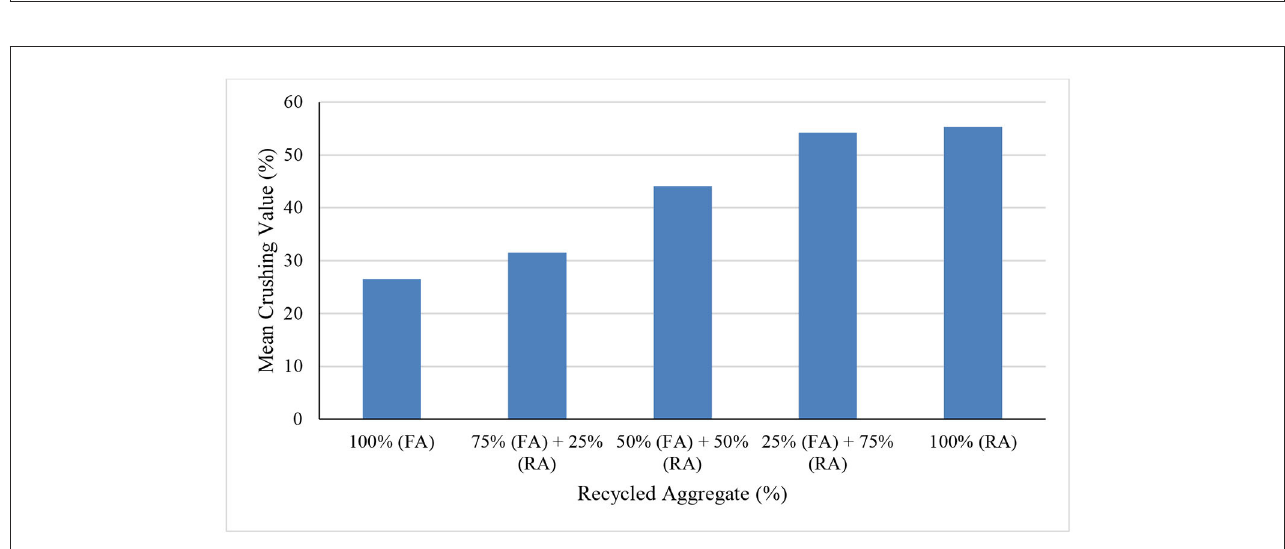
FIGURE4 Recycled aggregates crushing value at different percentages of